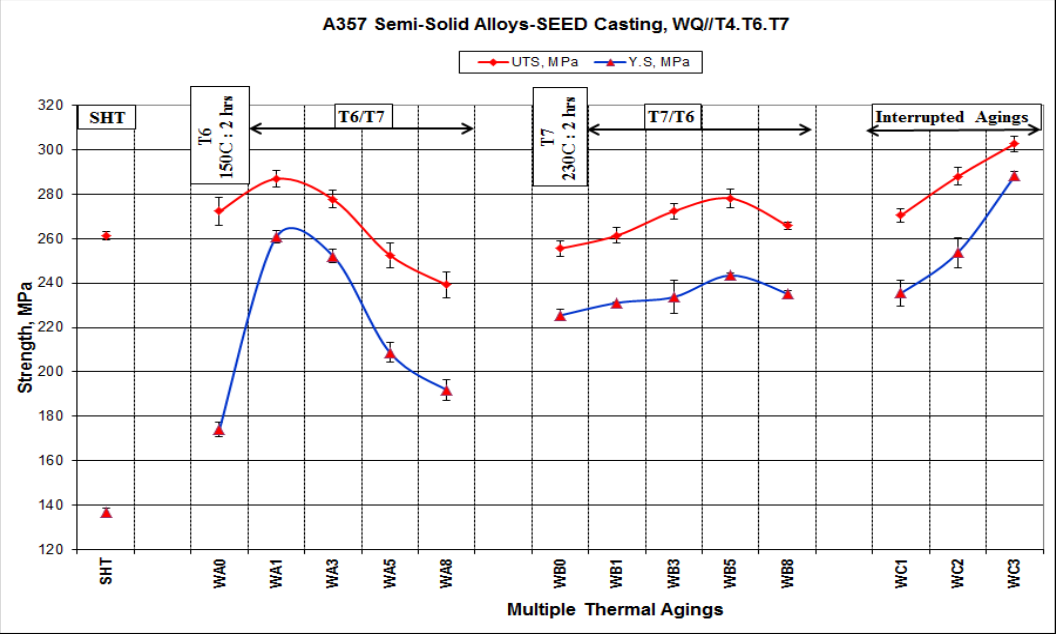
Figure 3. Tensile strength values of water quenching A357-SSM heat treated using multiple thermal aging treatments. Metals 2018 , 8 , x FOR PEER REVIEW